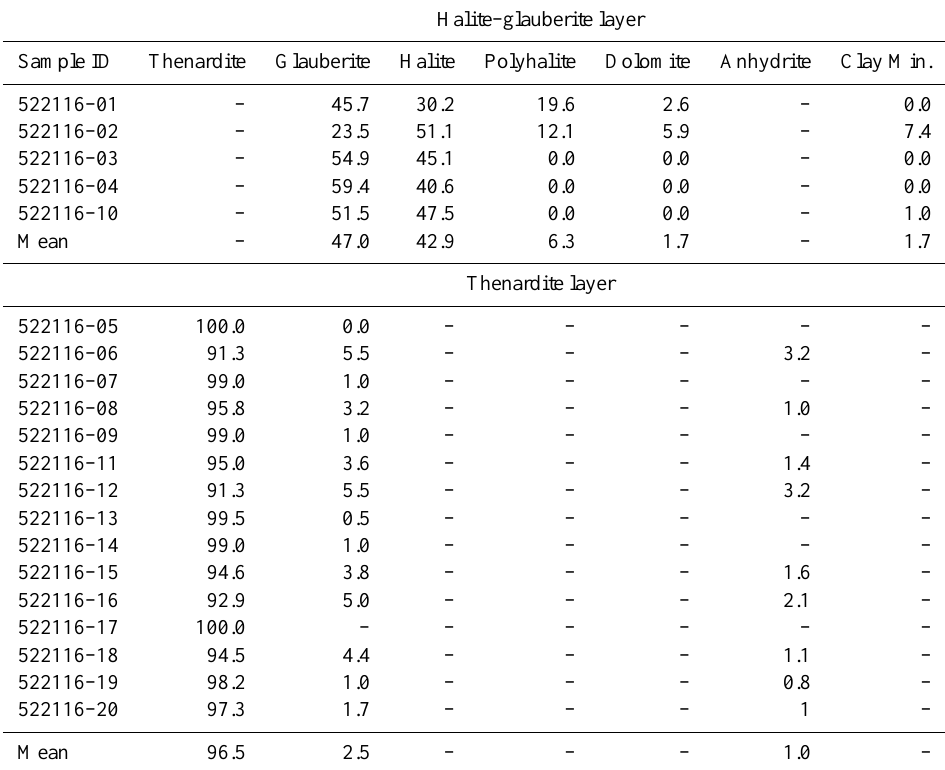
Table 1. XRD mineralogical composition of the